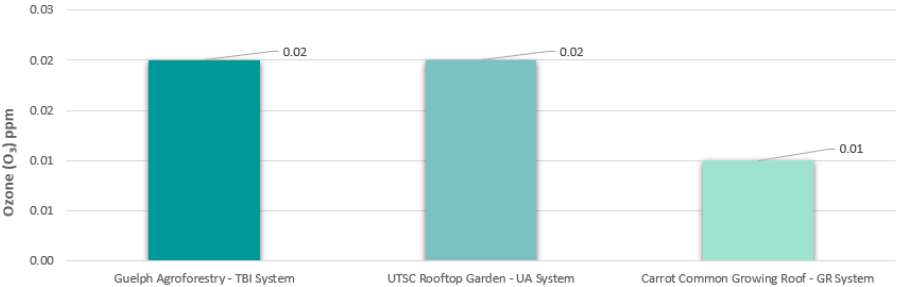
Figure 4. Average ozone (O 3 ) reduction in parts per millions (ppm) from June to October 2017—Tree-based Intercropping (TBI) System: Guelph Agroforestry Research Station; Urban Agriculture (UA) Systems: UTSC Rooftop Garden; and Green Roof (GR) Systems: Carrot Common Growing Roof.